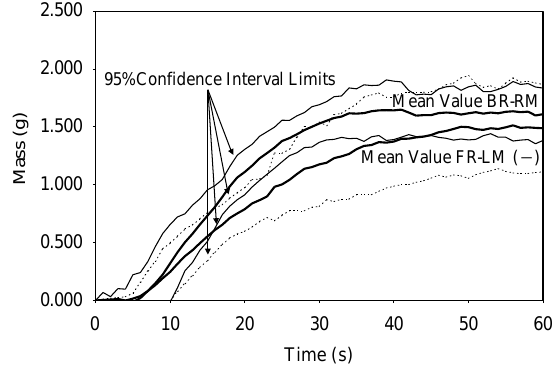
Fig. 3 Mean measured mass versus time relationships for Cell BR-RM and Cell FR-LM and the 95% confidence